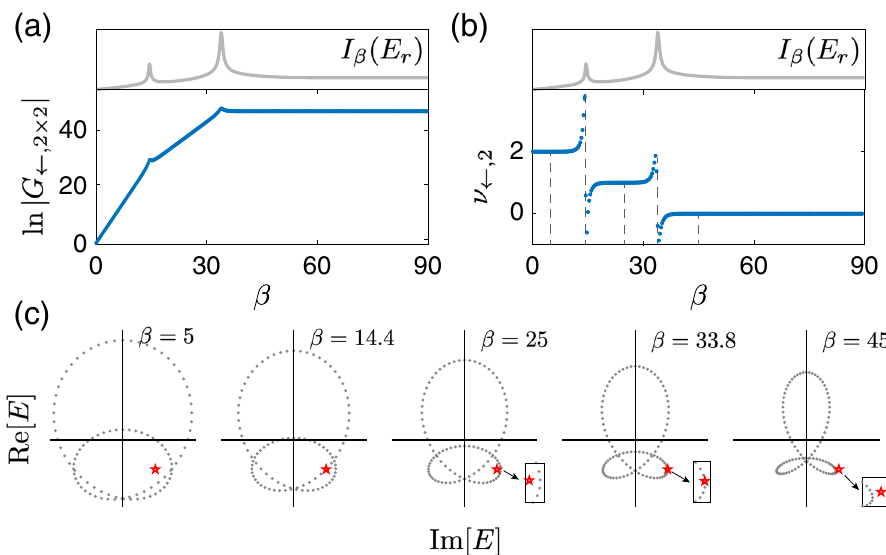
Fig. 2 Quantized plateaus in the interpolation of the system between periodic and open boundary conditions. a Ampli fi cation ratio ∣ G ← ,2×2 ∣ given by the of the two-by-two off-diagonal block of the Green ’ s function, and b ν ; 2 ¼ ∂ ln j G ; 2 ´ 2 j = ∂ β , as a function of β , with β controlling the boundary condition, along with the previously de fi ned I β ( E r ), whose peaks match well with the jumps between different plateaus. c Spectrum at different values of β , corresponding to the fi ve dashed lines in ( b ), respectively. Red stars indicate the reference energy E r = ω + i γ , with ω = − 0.96 and γ = 1. Insets zoom in on the regime around E r to give a clearer view of the relation between the shown spectrum and E r . Parameters are set at t 1 = 1, t − 1 = 0.5, t 2 = 2, t − 2 = 0, and N =